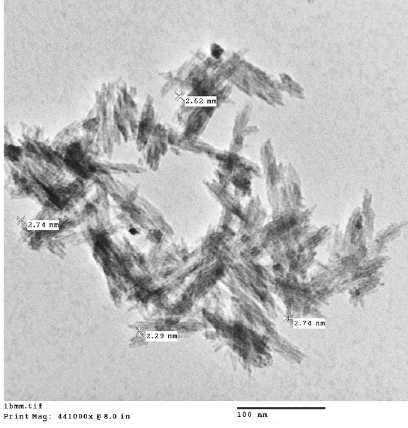
Figure 4: TEM image of TiO 2 nanoparticles.